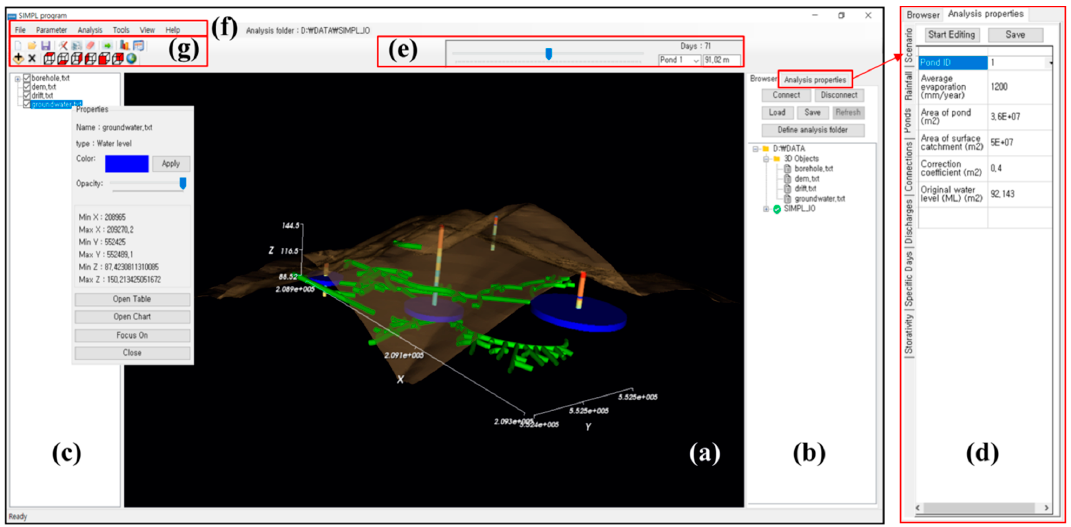
Figure 3. Graphical user interface of the SIMPL program. See the main text for label descriptions.